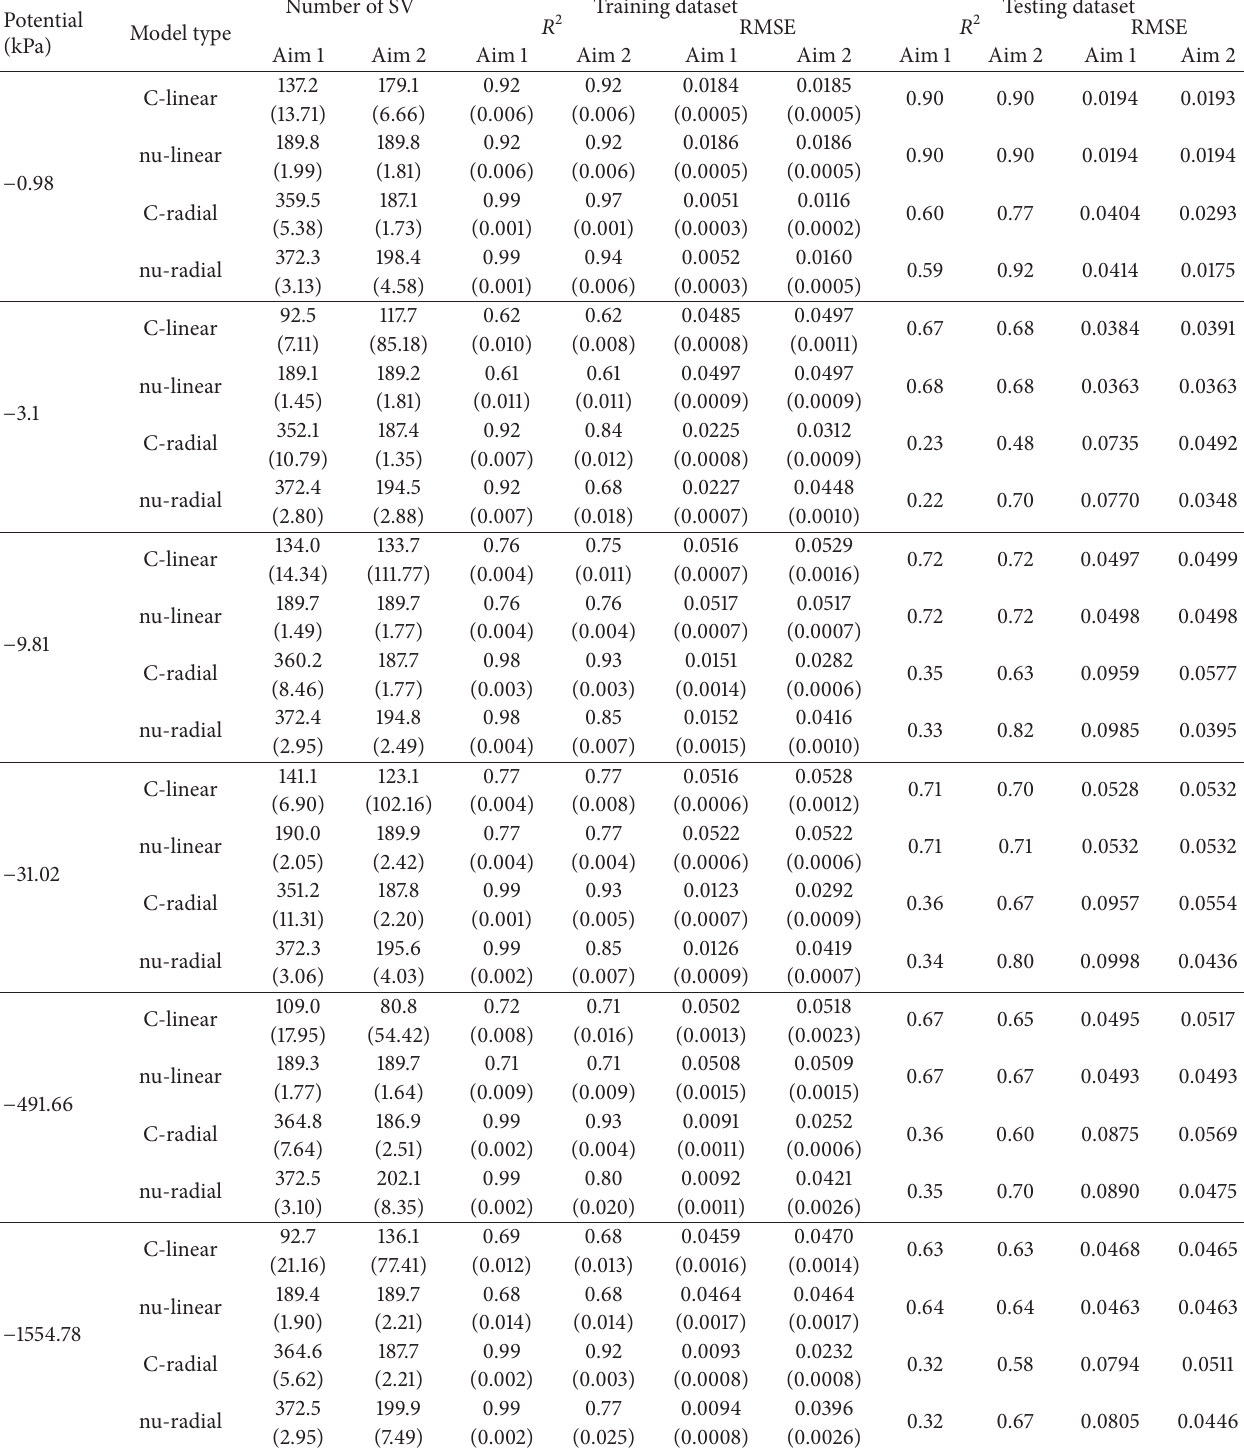
Table 3: Developed models performance